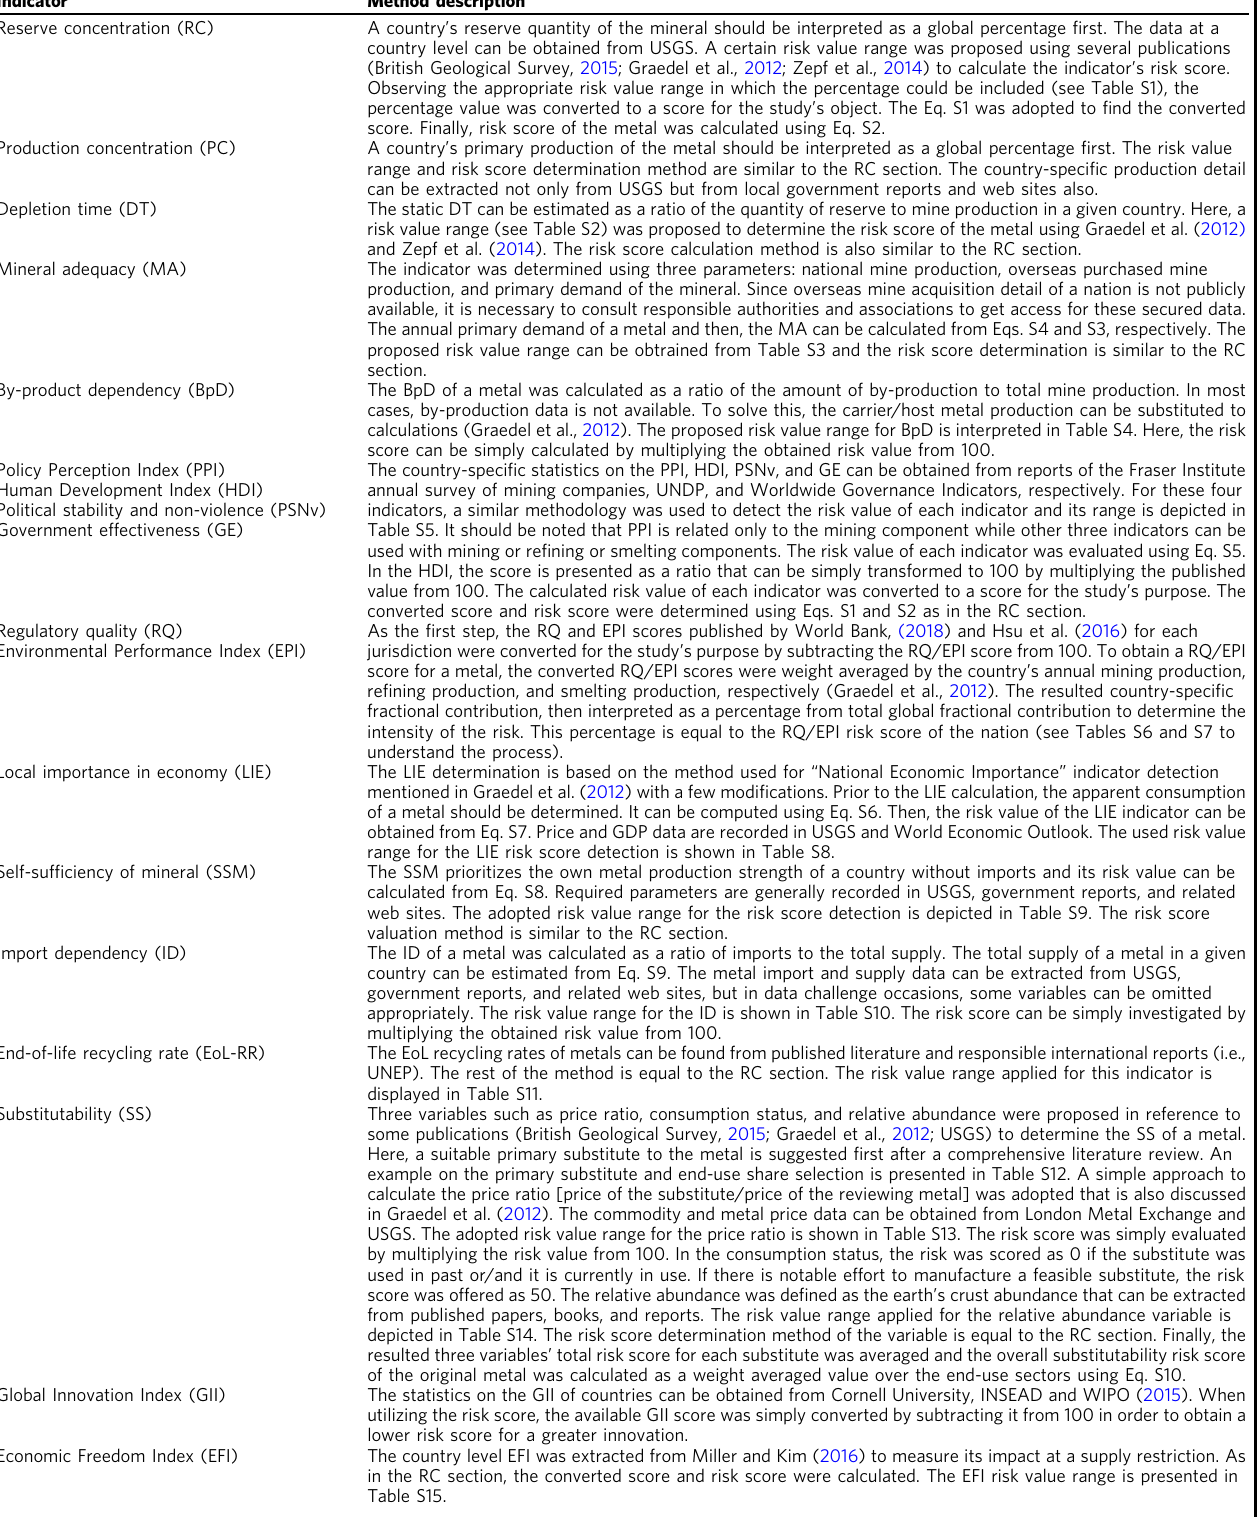
Table 1 A summary of assessing the indicators ’ criticalities. Further detail is elaborated in the Supplementary